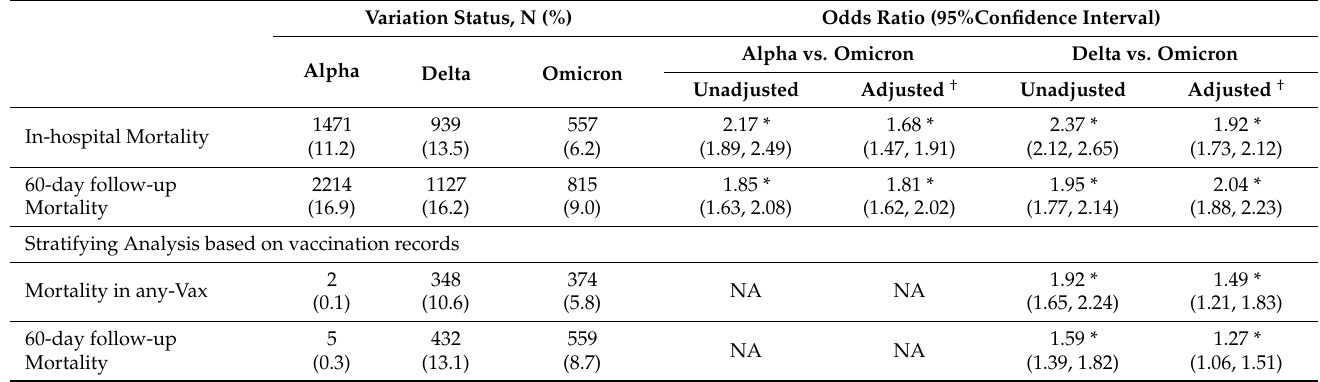
Table 3. Comparing in-hospital mortality among three variation groups: Alpha, Delta, and Omicron after the COVID-19 test.